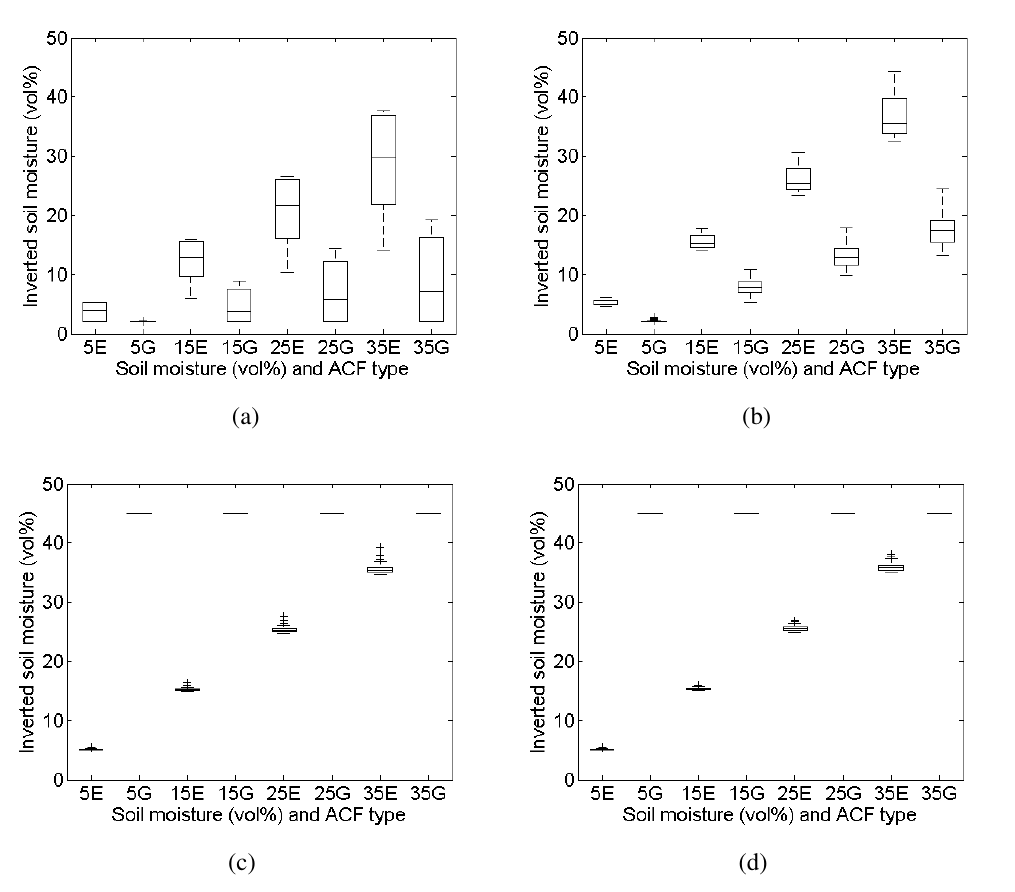
Figure 12. Boxplots of inverted soil moisture contents, calculated using roughness param- eters from resampled profiles with 15-mm spacing, and exponential (E) and Gaussian (G) autocorrelation functions, for initial moisture contents of 5, 15, 25 and 35 vol%, and all de- fined sensor configurations, for profiles with ( s , l ) equal to (a) (2 cm,5 cm), (b) (1 cm,5